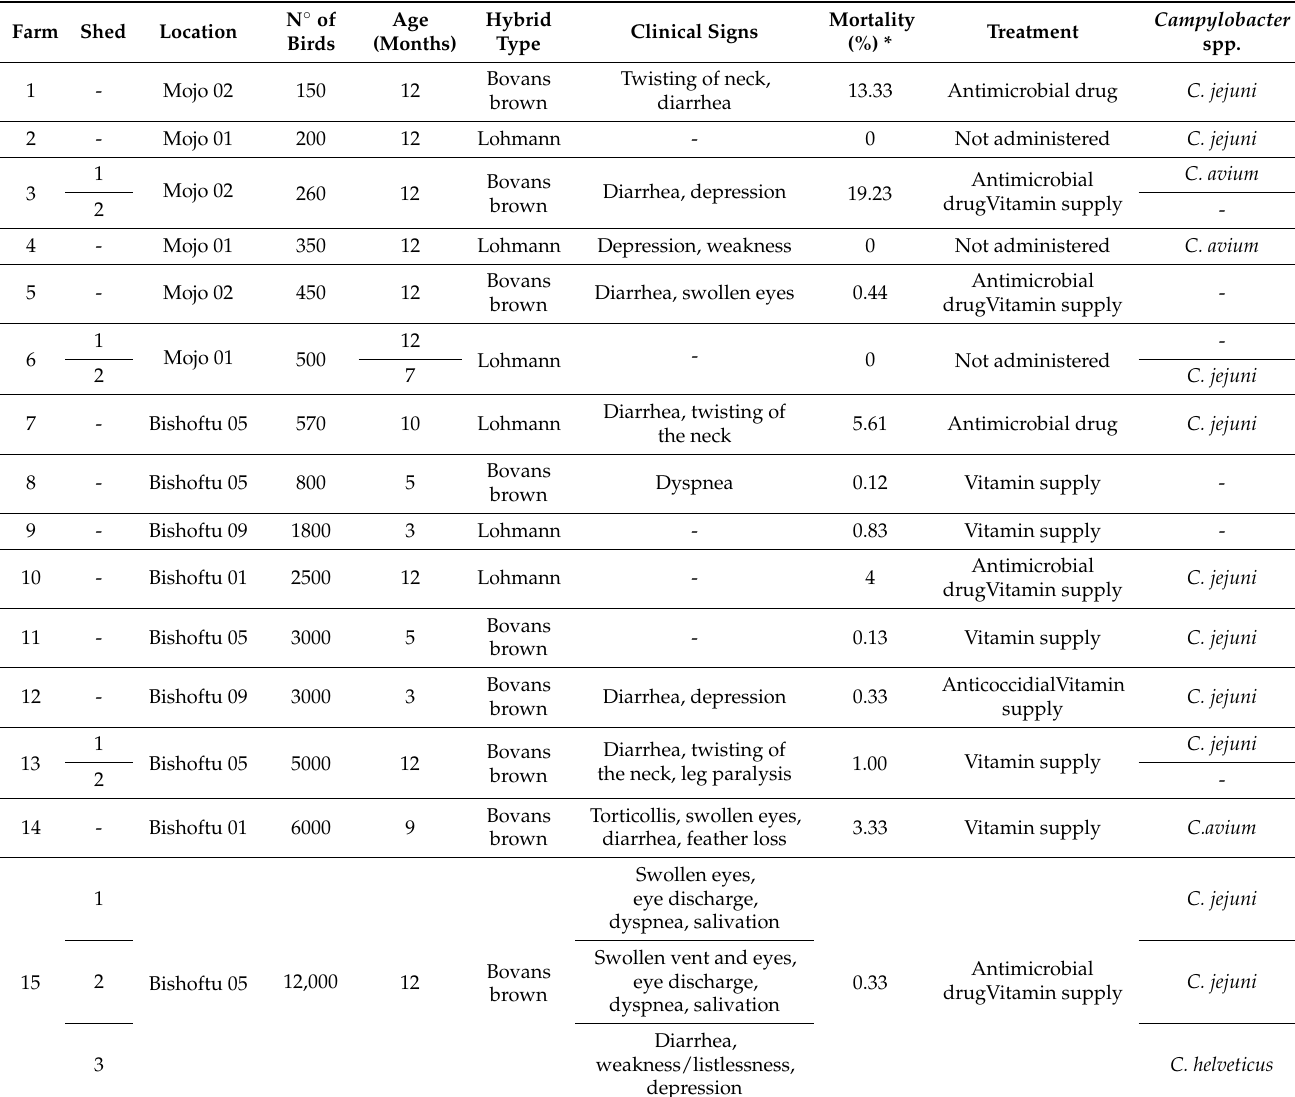
Table 1. Information summary of data related to the sampled